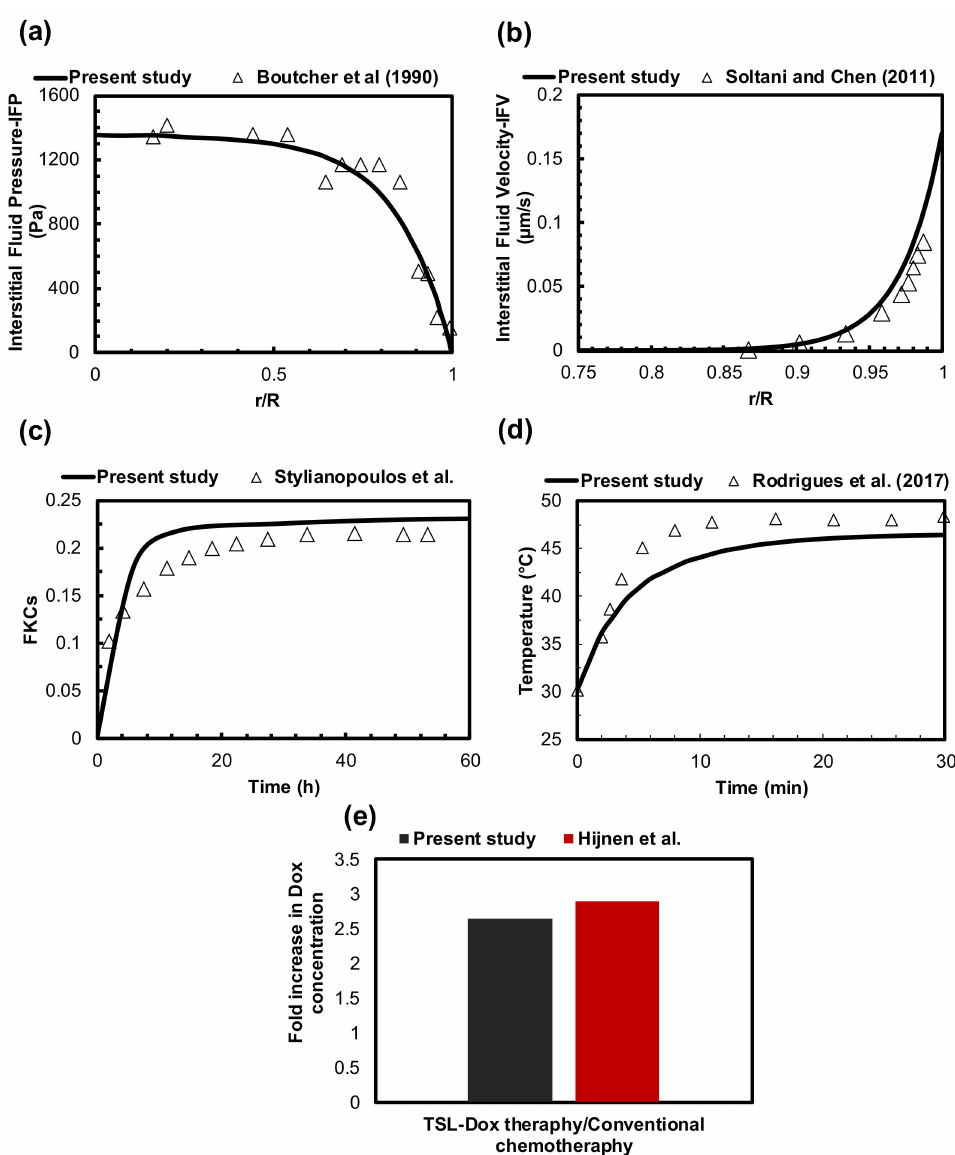
Figure 2. Validation of the current model performance. ( a ) The numerically calculated IFP distribu- tion was validated with the experimental data from the literature. ( b ) The comparison of obtained IFV values with the theoretical amounts of previously published studies. ( c ) The value of FKCs compared to experimental results obtained 60 h after conventional chemotherapy taken from previously pub- lished studies. ( d ) Temperature comparisons between numerical simulation and experimental results of MHT on murine under the same conditions. ( e ) Qualitative verifications of TSL-Dox delivery in the present study and those in the